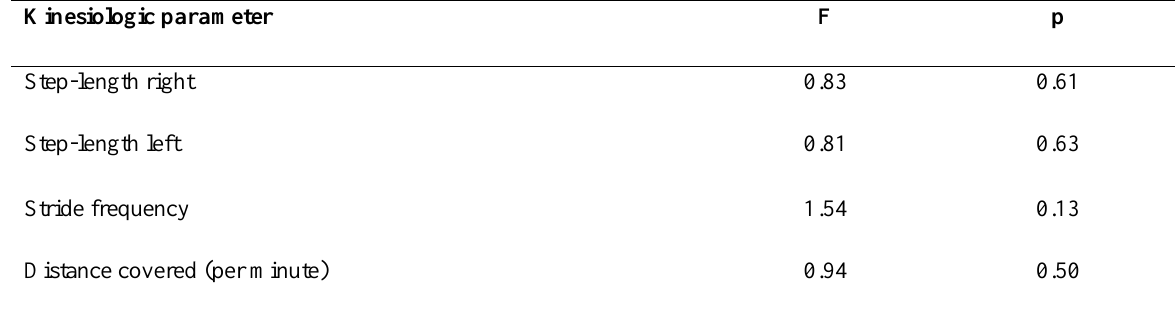
Results of ANOVA with repeated measurements over time Kinesiologic parameter